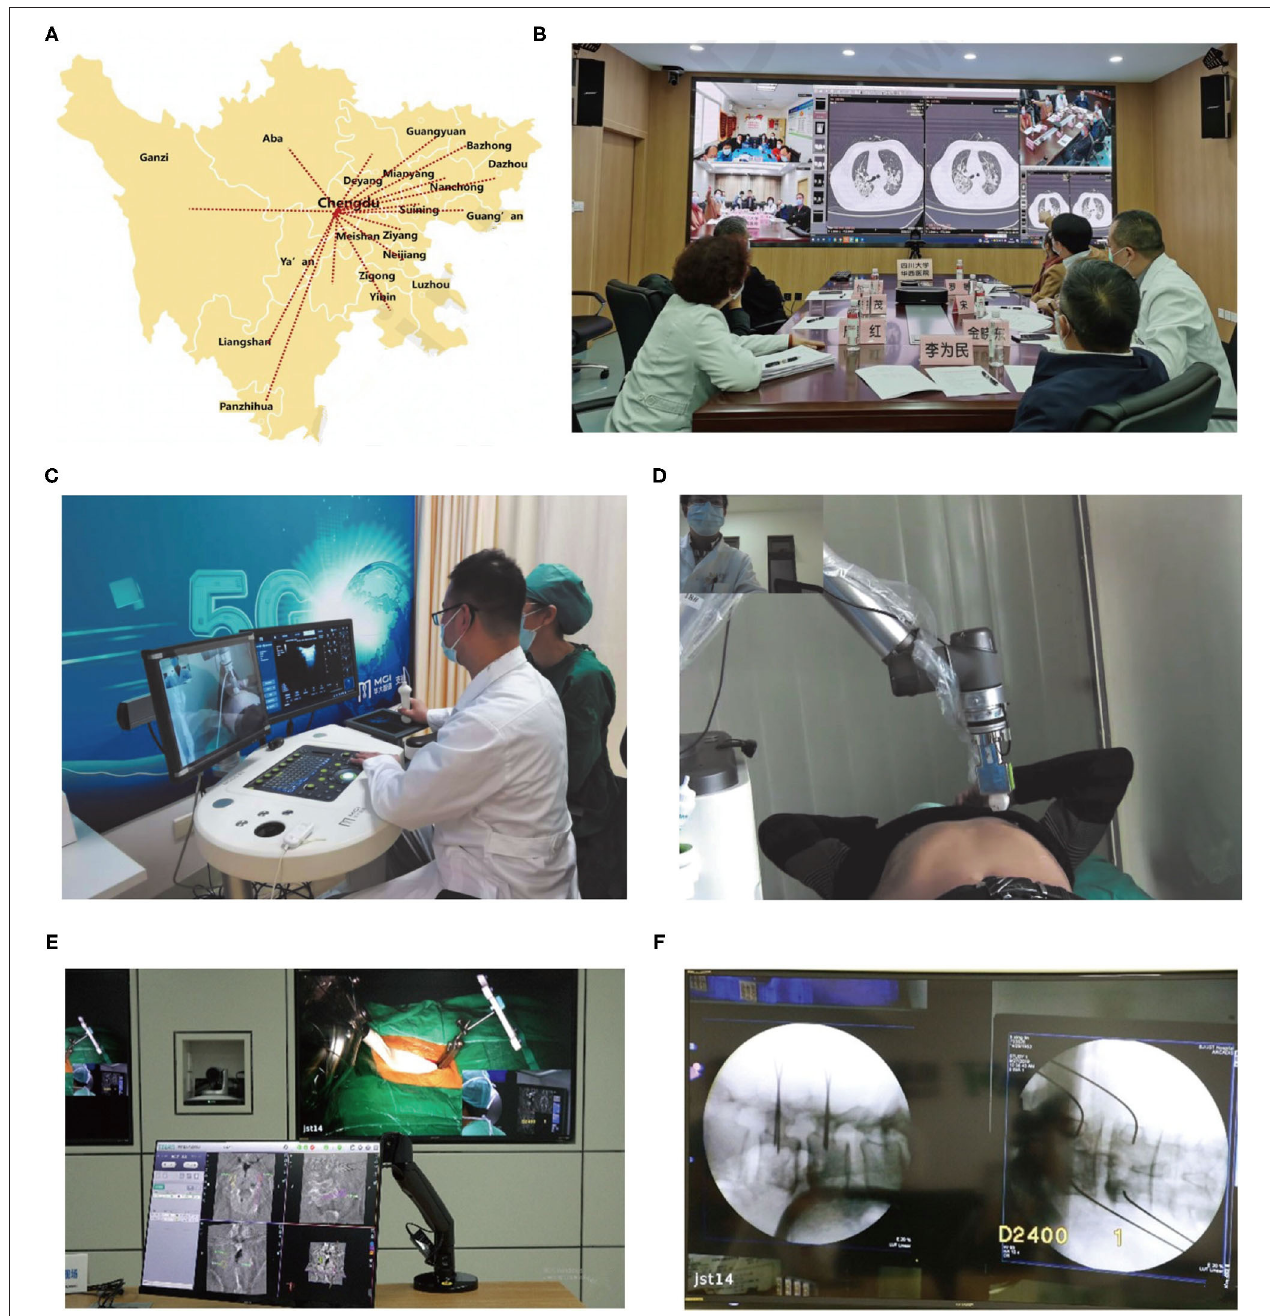
FIGURE 5 | Telemedicine based on fifth-generation (5G) network and robotic technology for disease diagnosis and treatment during the COVID-19 outbreak. (A) 5G telemedicine platform of Sichuan Province of China developed during this pandemic. (B) The web-based real-time video tele-consultation provided by a multidisciplinary medical team based on “5G Dual Gigabit network” to deal with cases vulnerable to severe COVID-19 in western China (57). (C,D) 5G remote robotic ultrasound diagnostic system used in Fangcang shelter hospitals (82). (E) 5G network-based tele-ultrasound system tele-robotic spinal surgery including screw planning at master control room and (F) K-wire placement